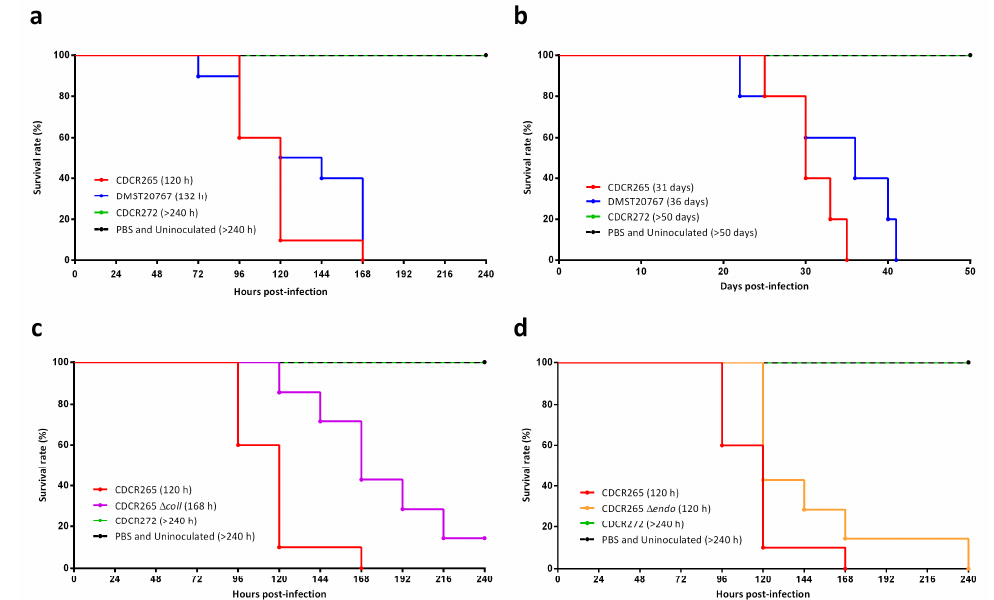
Figure 3. Log-Rank survival curves and median survival times (MST) of 10 Galleria mellonella larvae ( a ) and six female BALB / c mice based on data previously obtained by our group [13,14] ( b ) inoculated with di ff erent Cryptococcus gattii strains. G. mellonella inoculated with the knockout mutant strains ∆ coll ( c ) and ∆ endo ( d ) were compared with the high-virulence strain CDCR265 and the low-virulence strain CDCR272. The MST for each strain is given in brackets. Larvae ( a , c , d ) and mice ( b ) inoculated with phosphate-bu ff ered saline (PBS) and uninoculated controls are shown (dotted line).